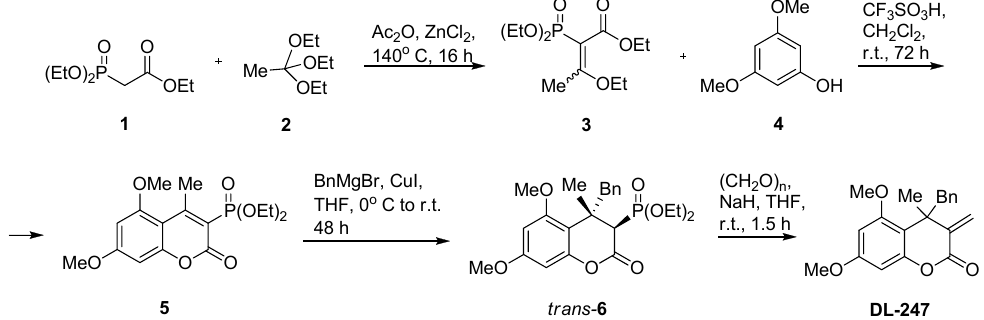
Figure 1. Structures of coumarin, parthenolide, vernolepin and a new hybrid DL-247